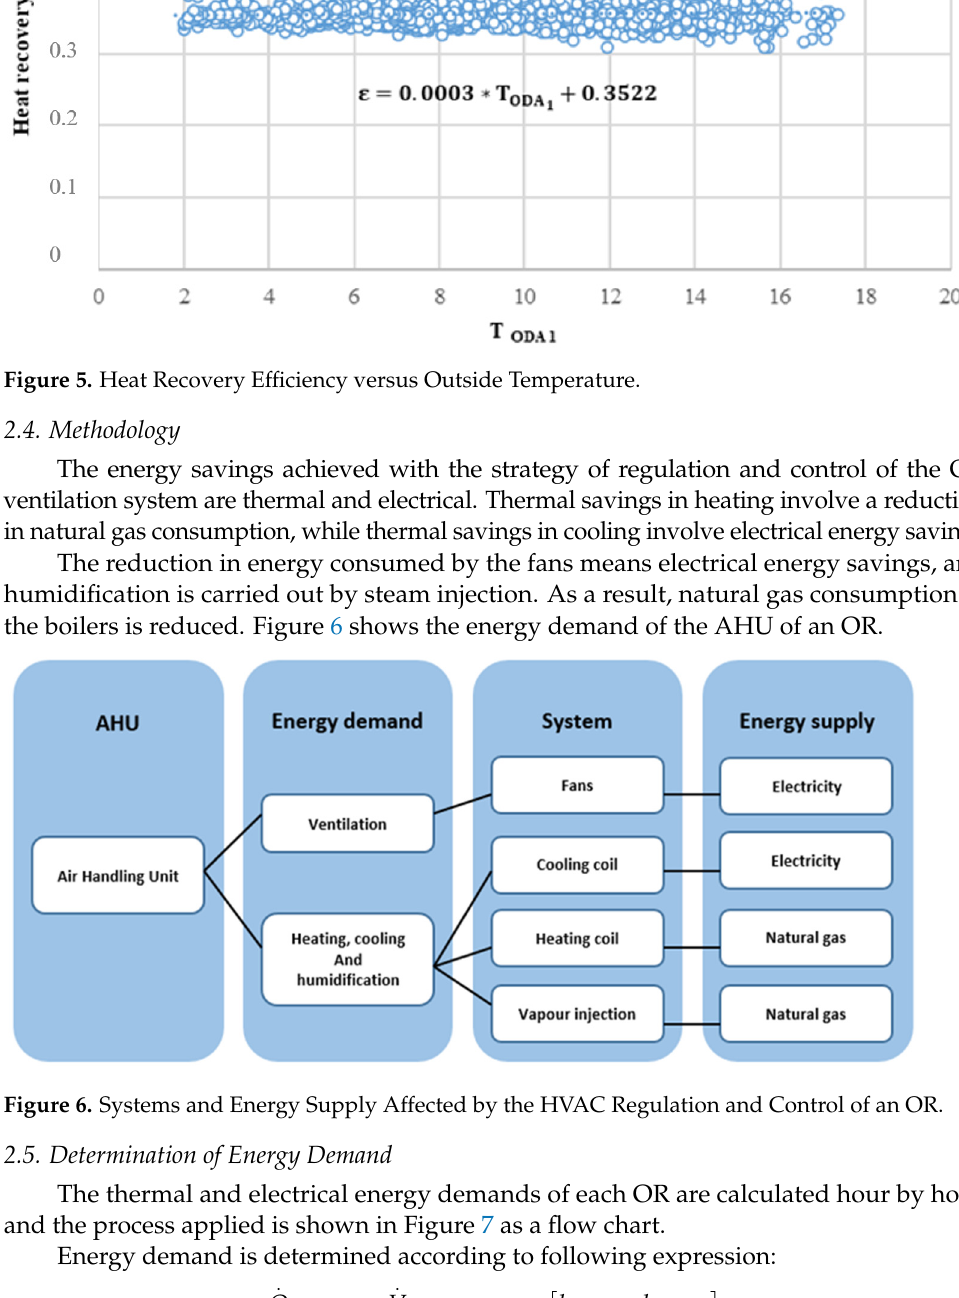
Figure 7. Flow Chart used to Assess the Thermal and Electrical Energy Demand of the Operating Rooms.